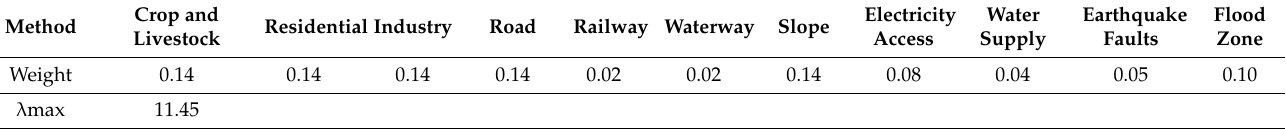
Figure 7. Constraint Variables for Restriction Map. Table 3. Evaluated Weight by AHP